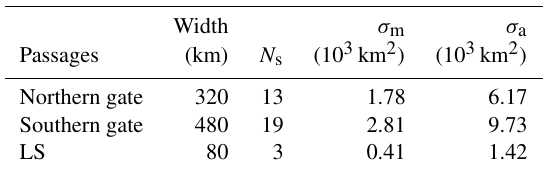
Table 1. Mean uncertainty estimates for sea ice area flux in terms of daily ( σ D ) , monthly ( σ m ) , and annual ( σ a ) fields for the period of 1978–1979 to 2016–2017. N s is the number of grid cells covered by the corresponding gate.